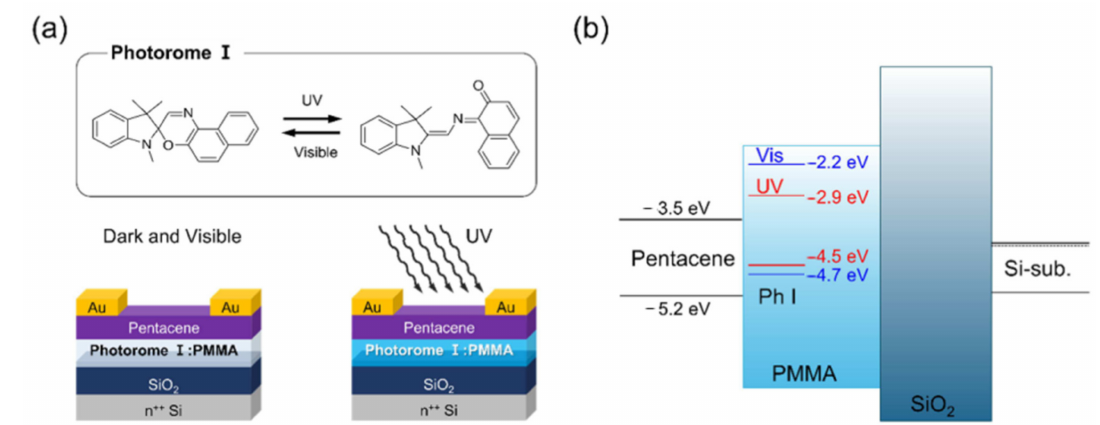
Figure 11. Schematic of ( a ) device structure and isomerisation process, ( b ) energy band gap during Vis and UV. Reprinted with permission from ref. [111]. Copyright 2020